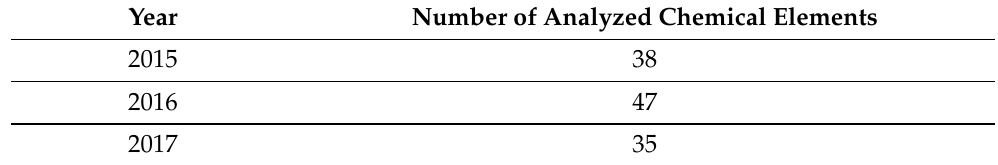
Table 2. Number of analyzed chemical elements for each